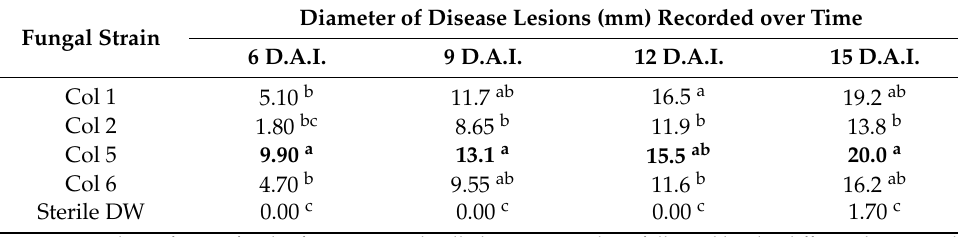
Table 3. Diameter of anthracnose lesions caused by four fungal strains over time. Diameter of Disease Lesions (mm) Recorded over Time Fungal Strain